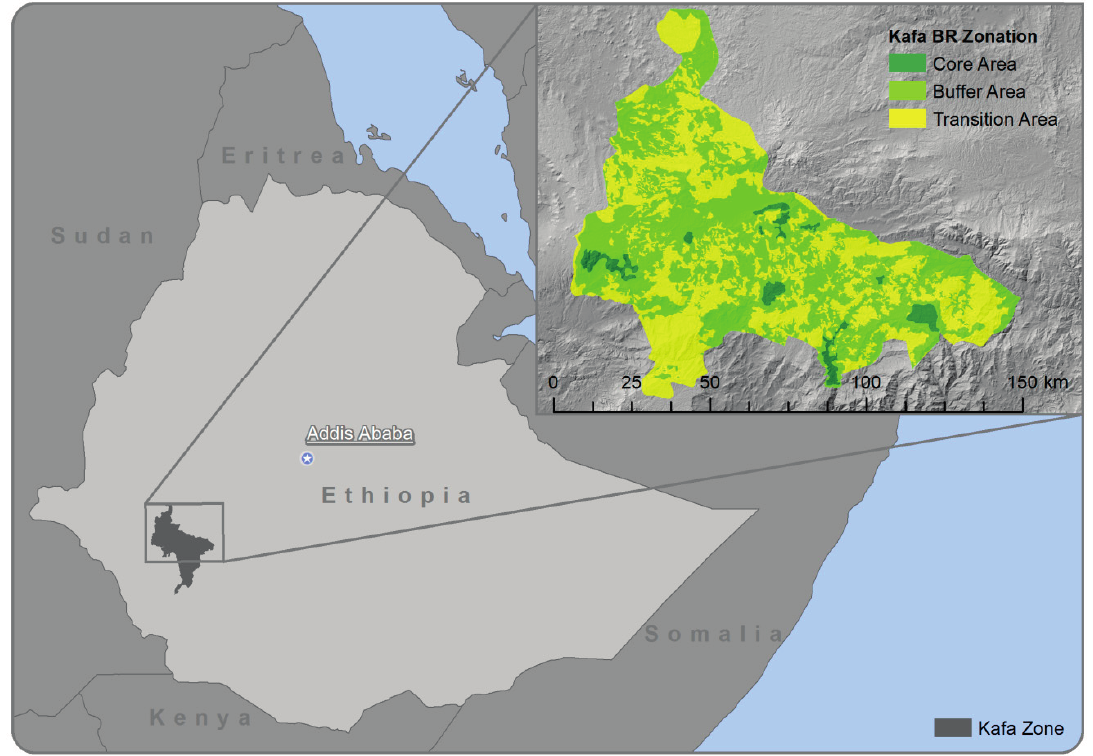
Figure 1. Geographic location of the UNESCO Biosphere Reserve and its zonation according to Man and Biosphere (MAB)